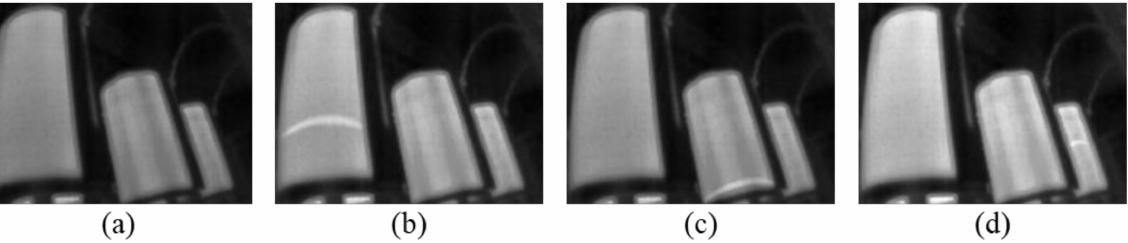
Figure 14. ( a ) The normal case. ( b – d ) The ITSC in phases R, S, and T. Separately, fault traces of different phases are